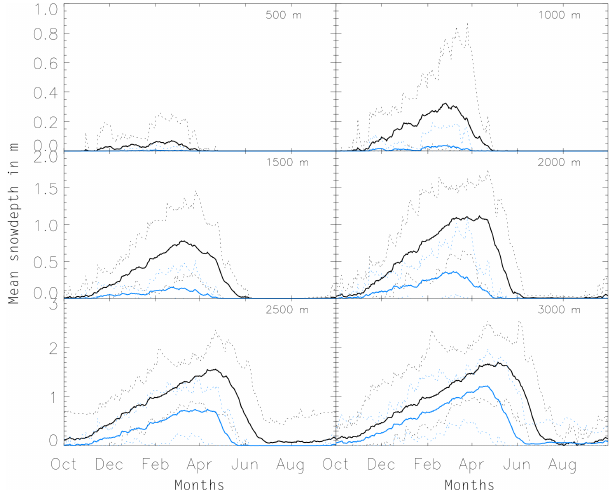
Figure 4. Mean (solid), maximum and minimum (dotted) snow depth for the reference period (black) and the A2 2085 scenario (blue) in the Aare domain for 6 elevation zones. The elevation zones are 100m wide, i.e., the 1500m zone, contains all pixels between 1450 and 1550m. Note: the scale of the y axis changes with eleva-